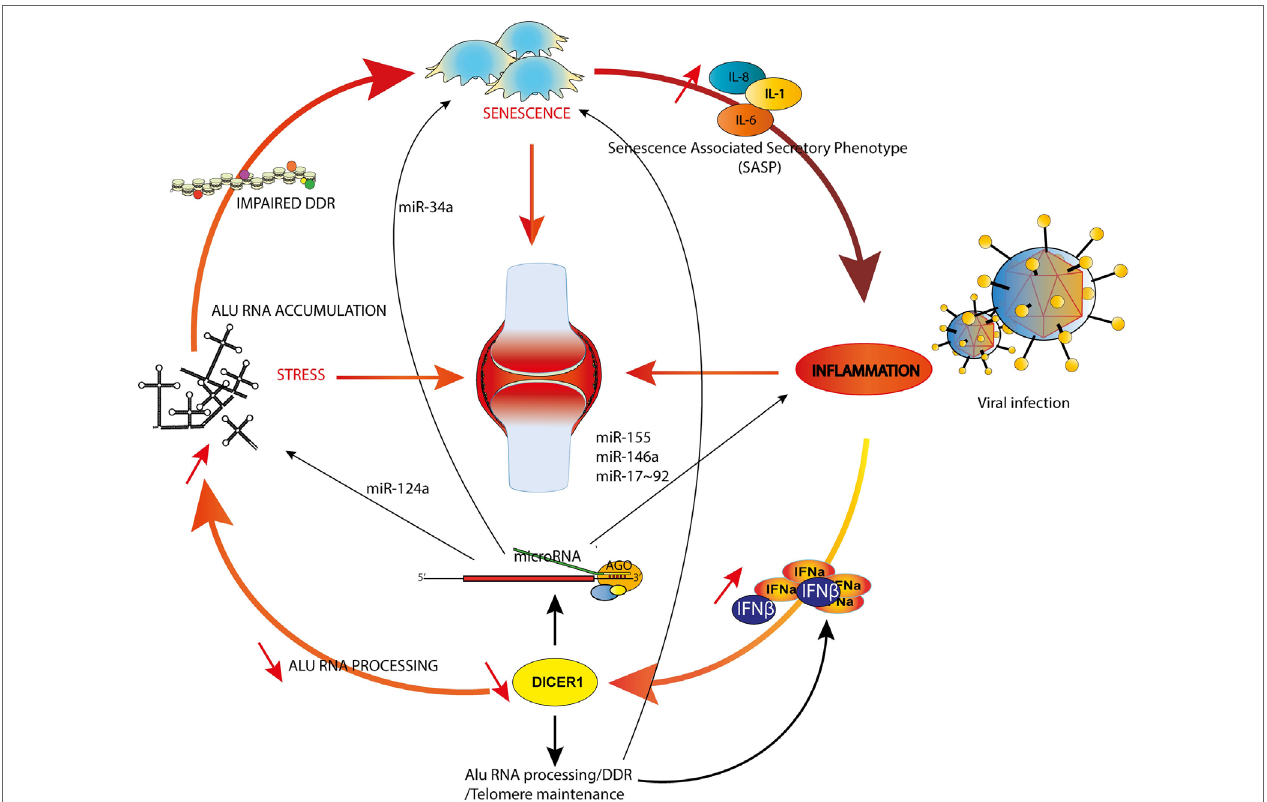
FiGuRe 2 | DICER1 functions at the crossroads of inflammation, senescence and aging. Examples of microRNAs involved in both rheumatoid arthritis (RA) and inflammation (miR-155 and -146a), RA and senescence (miR-34a) or RA and stress (miR-124a) are shown. The model illustrates how an initial trigger (e.g., a viral infection) might initiate a vicious circle (see